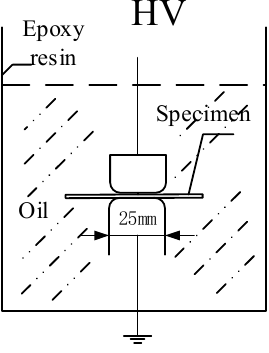
Figure 6. Direct-current (DC) breakdown electric field strength test system.